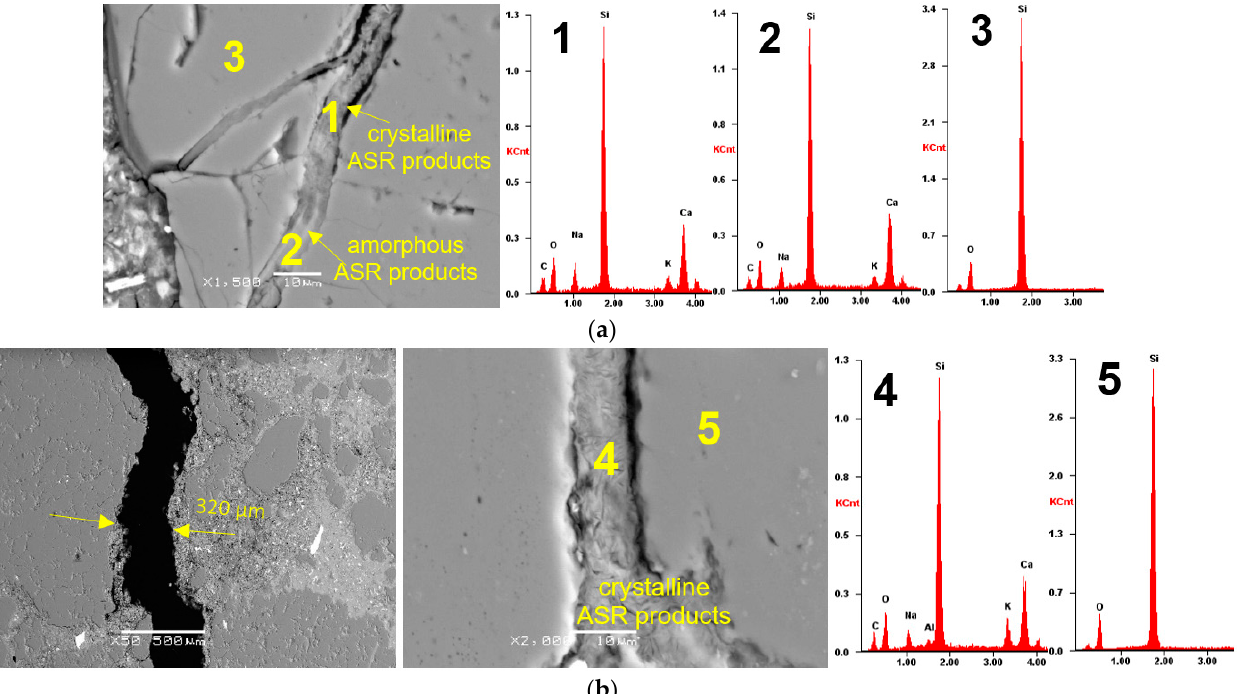
Figure 6. Microstructure of the mortar with aggregate Q after 28 days of storage at 80 °C in ( a ) 1 M NaOH, cracks in the aggregate grain filled with crystalline (1) and amorphous (2) ASR products; ( b ) 50% HCOOK, crack of 320 µm and crack in the aggregate grain filled with crystalline ASR products (4), quartz (5).